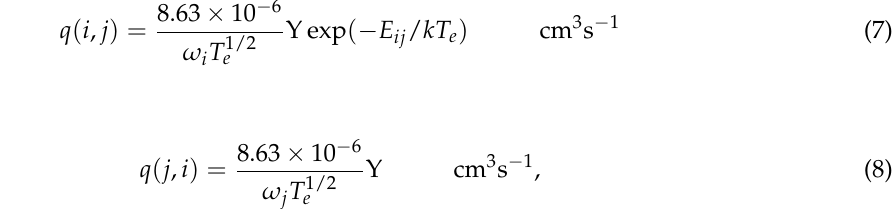
Figure 5. Comparison of collision strengths for the 14–15 (4d 2 D 5/2 –4f 2 F o and 23–24 (5g 2 G 7/2 – 5f 2 F o